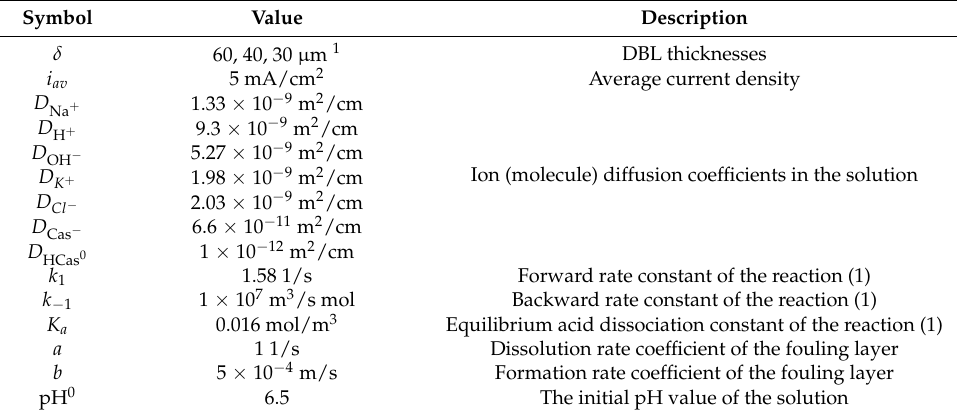
Table 1. Main input parameters used in the